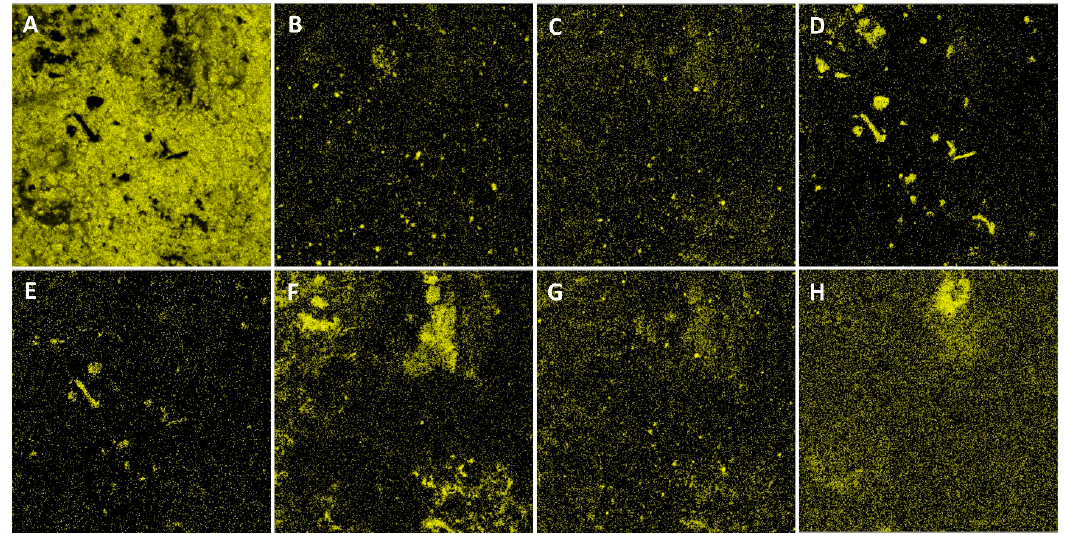
Figure 4. SEM-EDS elemental distribution maps for aluminum ( A ), silicon ( B ), molybdenum ( C ), copper ( D ), zinc ( E ), tin ( F ), lead ( G ) and magnesium ( H ) for M2 alloy.